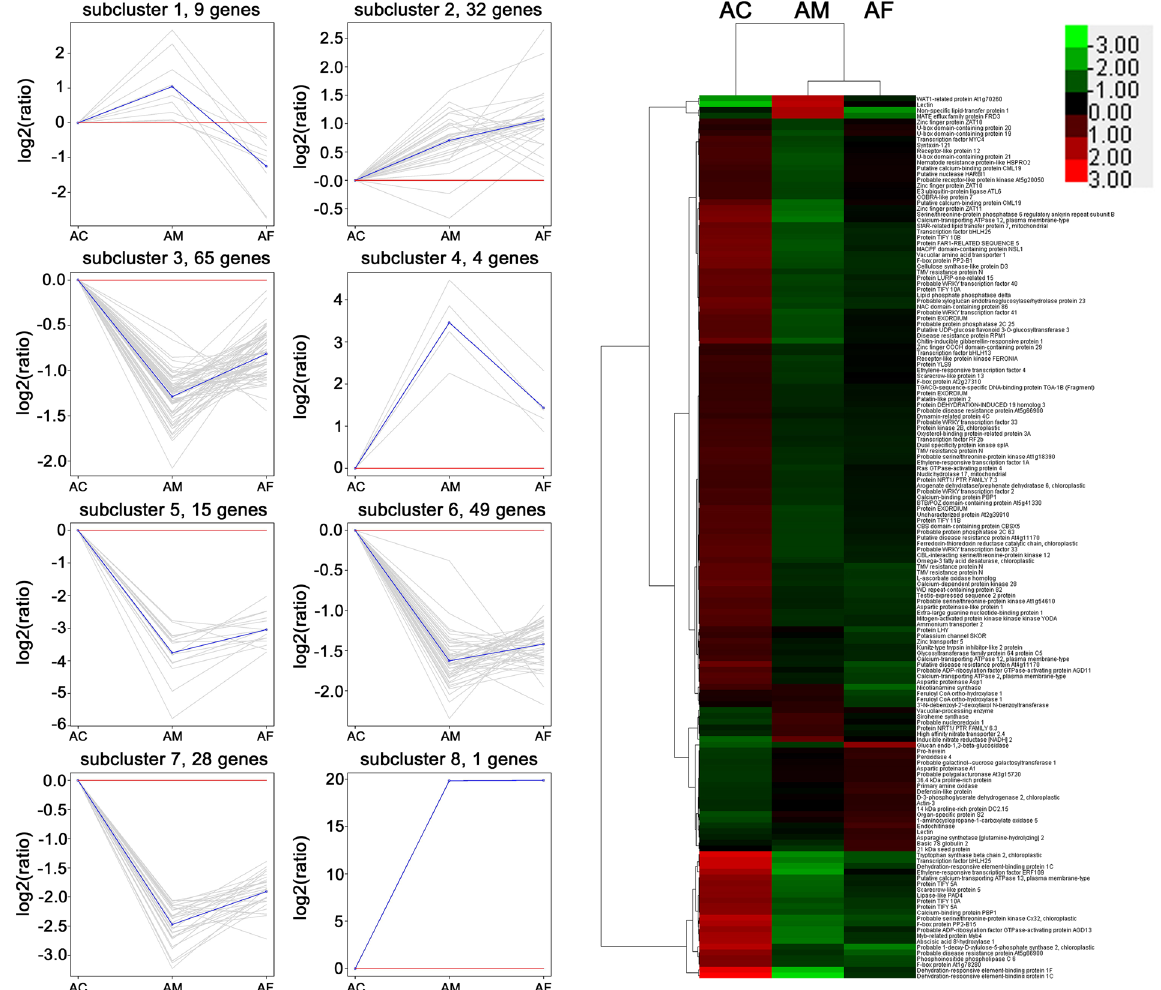
Figure 3. Cluster analysis of DEGs identified by Transcriptome comparisons of M . anisopliae treatment (AM), F . axysporum treatment (AF) and control (AC). Right: Heatmap of DEGs across the three treatments. Red indicates high expression and green indicates low expression. Chroma color from red to green indicates log10 (FPKM + 1) from more to less. Left: Expression patterns of the genes in the eight main clusters corresponding to the heatmap. Gray lines represent relative expression of a gene cluster under different experimental conditions, the blue line represents the average of the relative expression of all the genes in the cluster. Y-axis shows the Log2 (ratios) relative expression